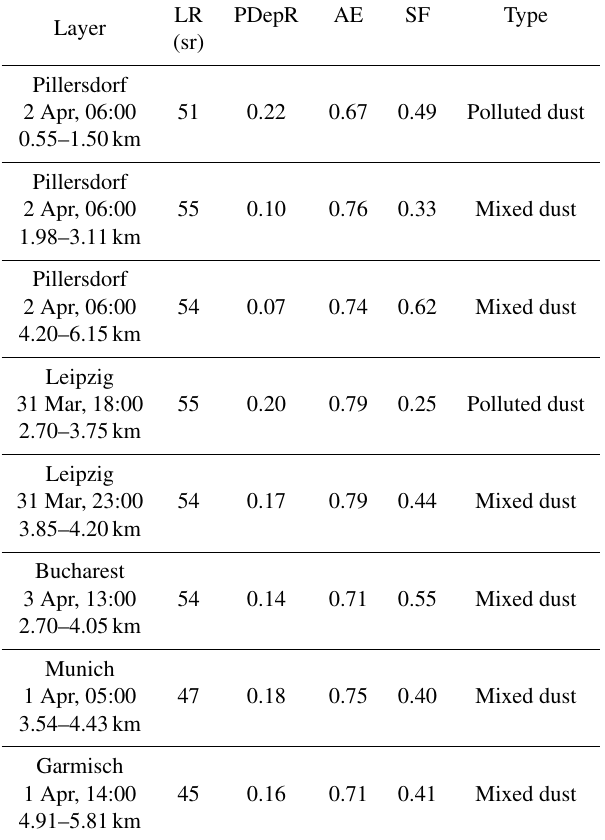
Table 3. Optical properties, sulfate fraction, and aerosol types for aerosol layers corresponding to Pillersdorf, 2 April 2014, 06:00.